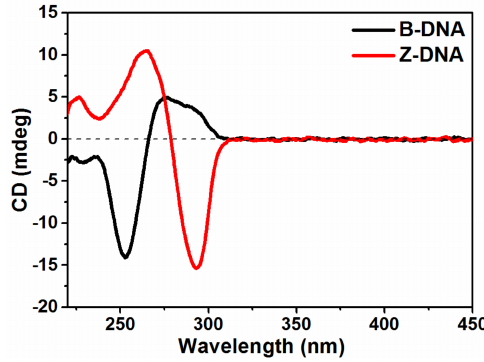
Figure 1. The CD spectra of B-DNA (50 µ M) and Z-DNA (50 µ M) in the presence of spermine (12 µ M) in Na-cacodylate buffer (1 mM, pH =